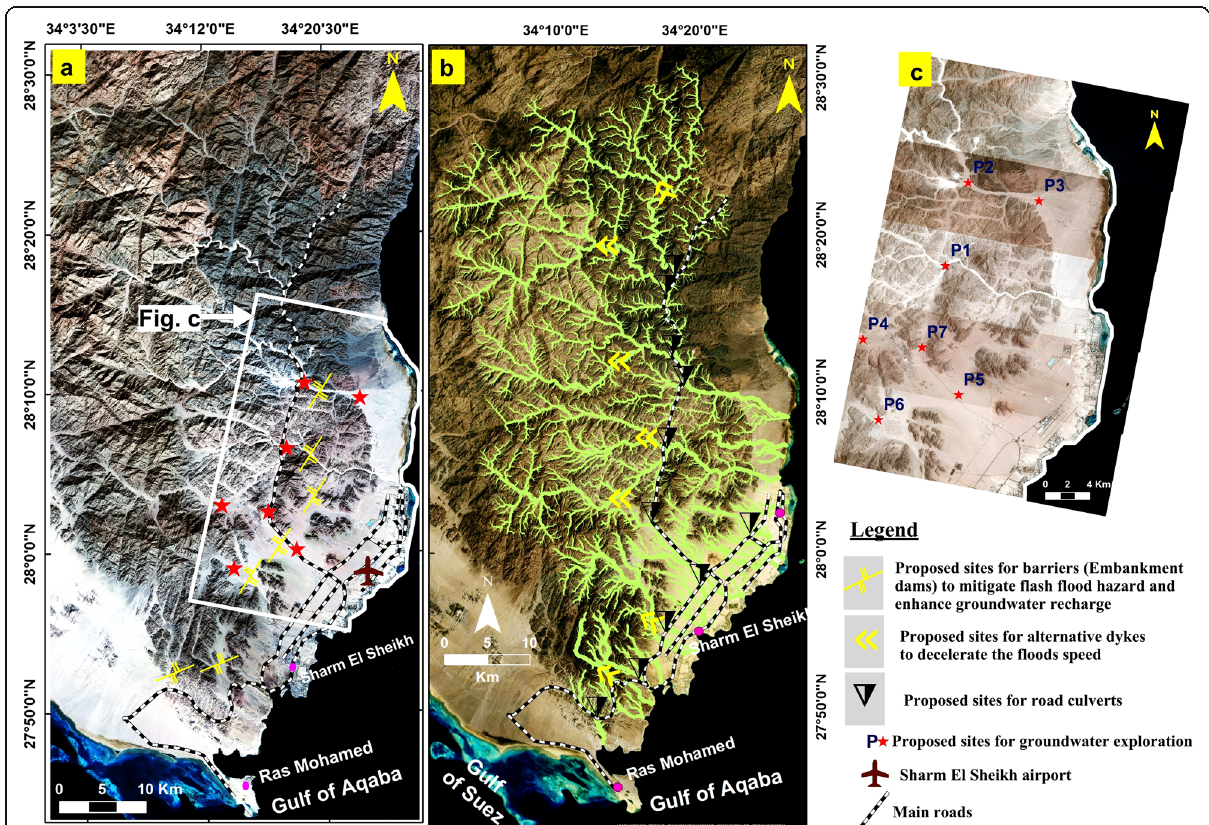
Fig. 14 Recommendations of the proposed sites to set up a controlling system to mitigate the flash flood hazards and maximizing opportunists of groundwater recharge. a Proposed sites for embankment dams (yellow symbol) to mitigate flash flood hazard and enhance groundwater recharge, as well as sites for groundwater exploration (red symbol). The sites are illustrated on sentinel satellite image (RGB,134) with pixel resolution 10 m. b Proposed sites for alternative dykes and road culverts are showing in Google Earth TM . c High resolution satellite image (planet, spatial resolution, 3 m) to display the proposed precision sites for groundwater